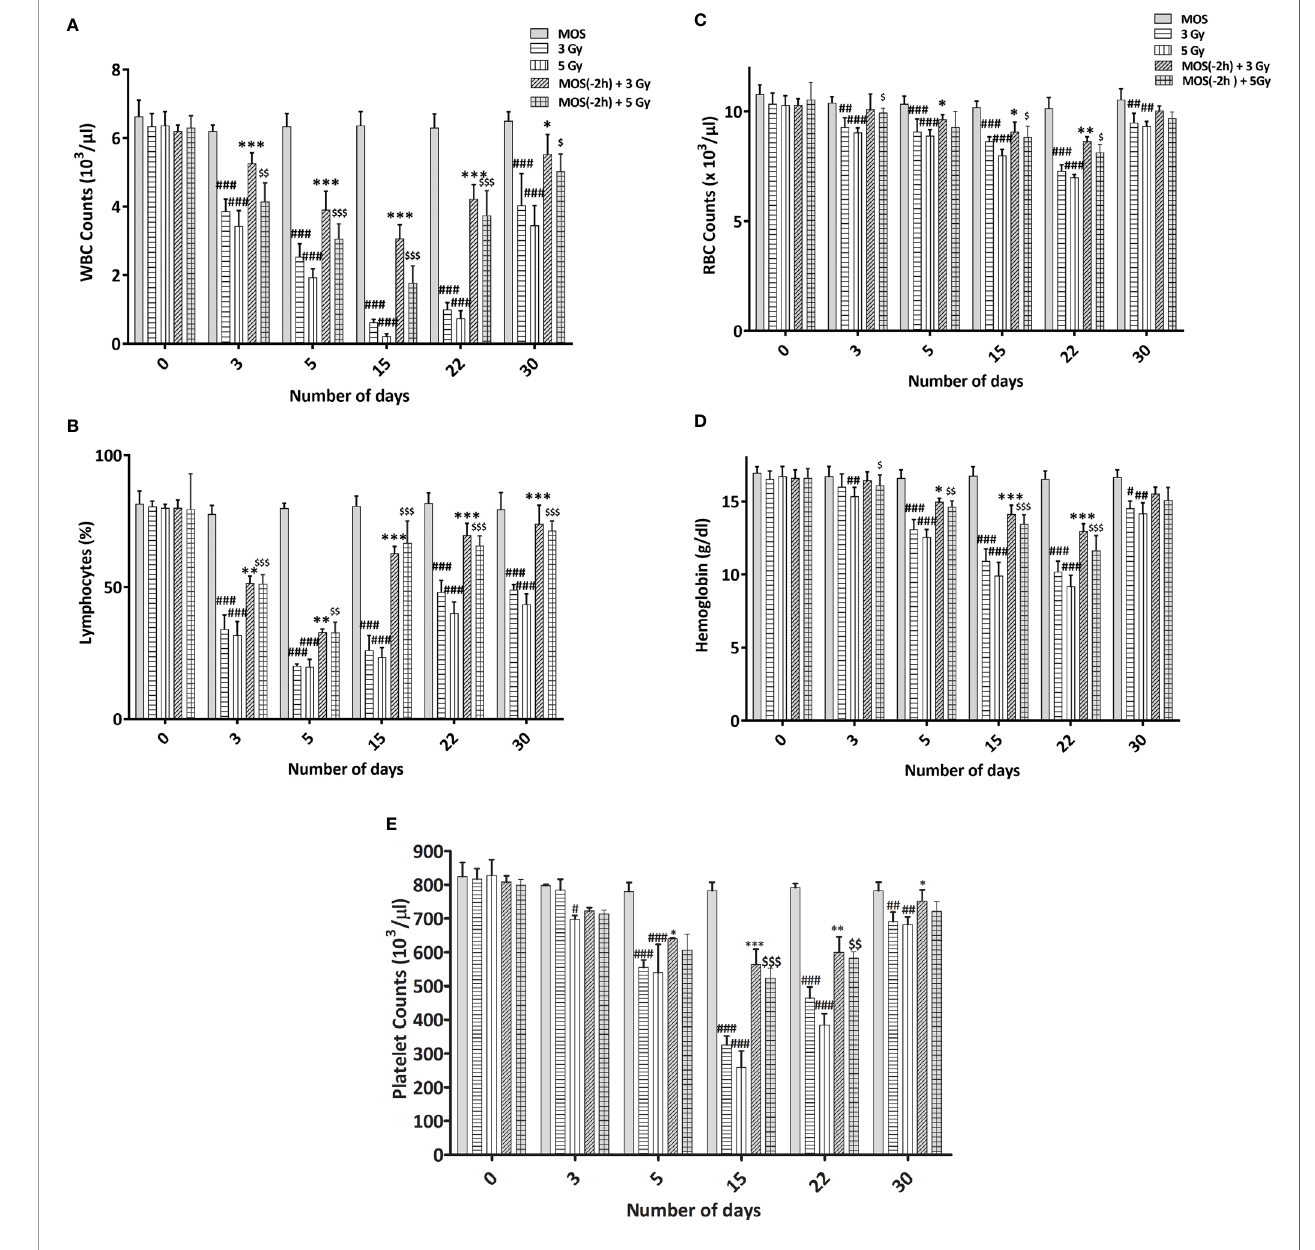
FIGURE 2 | (A – E) MOS mediated alterations in the hematological indices in the peripheral blood. Mice were treated with MOS and/or subjected to exposure of radiation (3 and 5 Gy) and assessed for blood cell parameters as described in Materials and Methods . Blood counts representing (A) WBC, (B) lymphocyte, (C) RBC, (D) hemoglobin, and (E) platelets at days 3, 5, 15, 22, and 30 post TBI. (n = 10). Error bars represent mean ± SD, and * p < 0.05, ** p < 0.01, and *** p < 0.001, # p < 0.05, ## p 0.01, ### p < 0.001, $ p < 0.05, $$ p < 0.01 and $$$ p < 0.001 were considered signi fi cant, #compared to unirradiated control,